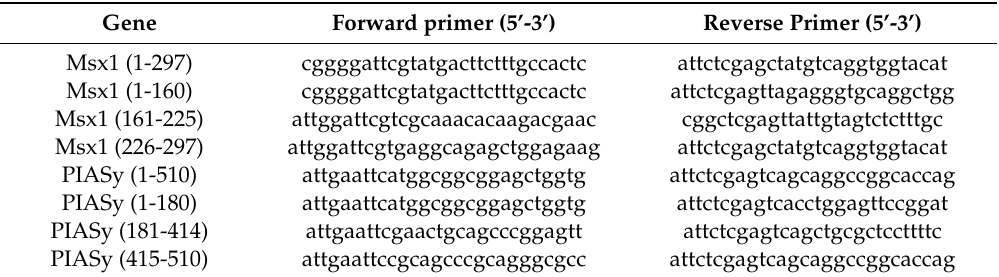
Table 1. Primer sequences used for yeast two-hybrid (Y2H)